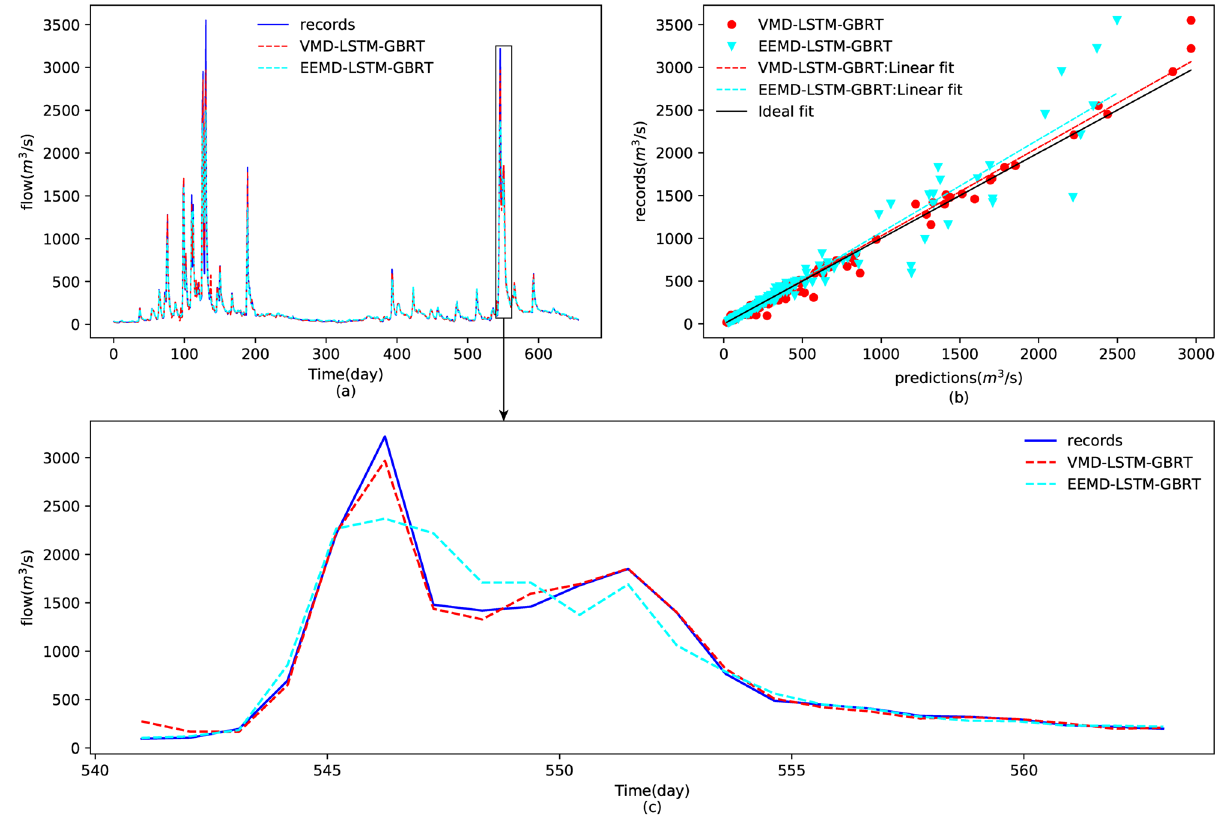
Figure 11. Comparison of prediction results of the test dataset using the different decomposition algorithms VMD and EEMD: ( a ) forecasting results, ( b ) scatters for the testing data (15/3/2013–31/12/2014), and ( c ) plots of the prediction results for the period